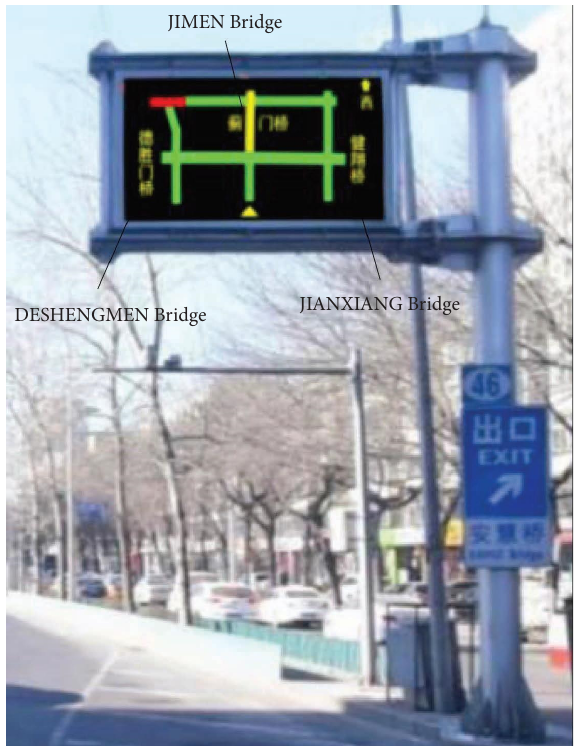
Figure 1: Example of graphical variable message signs in